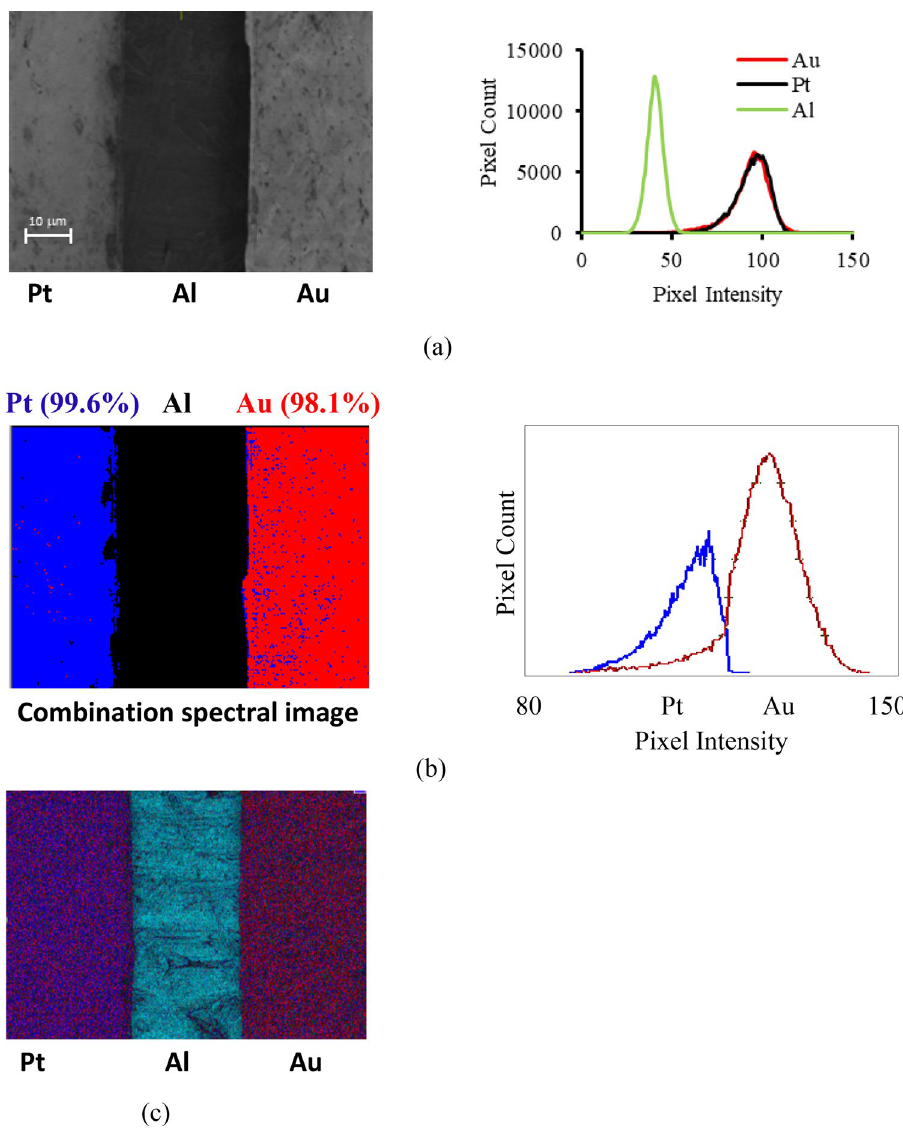
Figure 2. Quantitative material contrast mapping of Pt/Au foils on a Al base plate at a primary beam voltage of 1 kV ( a ) Conventional SE detector image/pixel intensity histogram. ( b ) Combination spectral image/pixel intensity histogram for k = 0.5. ( c ) EDX mapping at 2.5